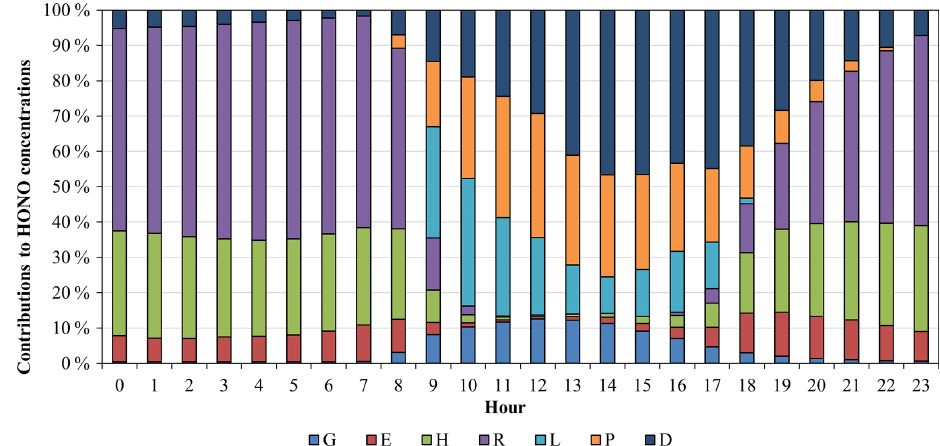
Figure 3. Average diurnal variations of contributions of different HONO sources to the simulated HONO mixing ratios at the Heshan site for 4–8 January 2017. The HONO sources include gas-phase homogeneous reaction of NO and OH (G), vehicle emissions (E), heterogeneous reactions under dark conditions with an RH of 50% (H), RH-enhancing effects on heterogeneous reactions (R), light-enhancing effects on heterogeneous reactions (L), photolysis of particulate nitrate in the atmosphere (P), and photolysis of HNO 3 and nitrate deposited on the surface